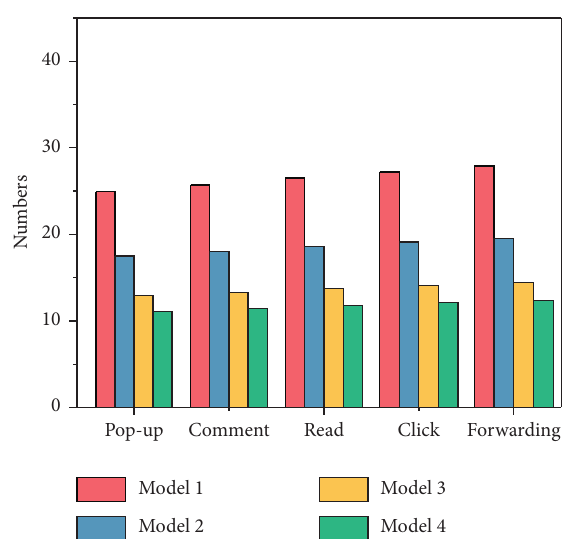
Figure 8: Modeling results for business Y